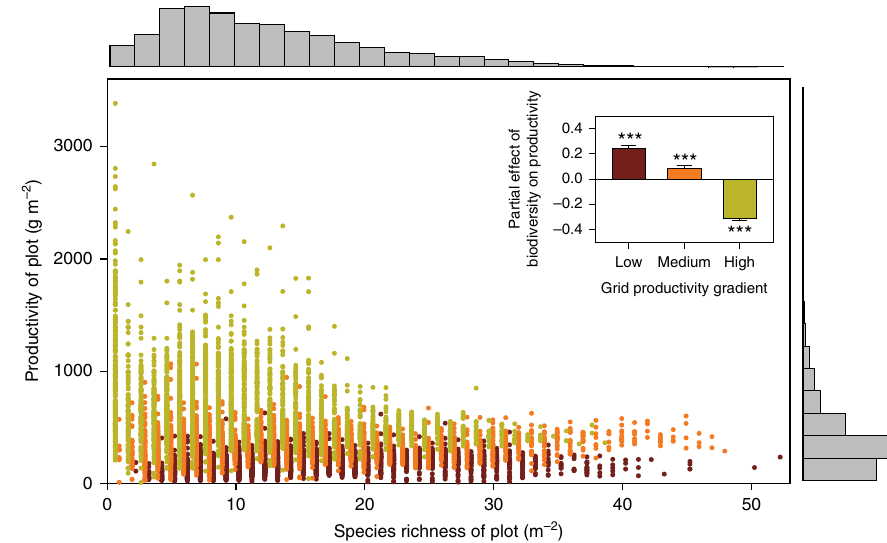
Fig. 3 Global relationships between biodiversity and productivity in natural grasslands at the plot level. Marginal histograms show the frequency distribution of biodiversity and productivity across plots ( N = 9640 plots). The 151 grids were divided into three equal groups depending on their mean productivity: low, medium, and high productivity (with 50 – 51 grids each), corresponding to different colors of the points (plots). Repeating the structural equation model analysis for the three groups separately, the partial effects mean±SD ð Þ of biodiversity on productivity along the productivity gradient are shown in the inset. Each bar corresponds to points of the same color. Symbols are slightly displaced at x -axis to improve readability. Asterisks indicate a signi fi cant difference from zero: * P < 0.05; ** P < 0.01; *** P < 0.001. Source data are provided as a Source Data fi